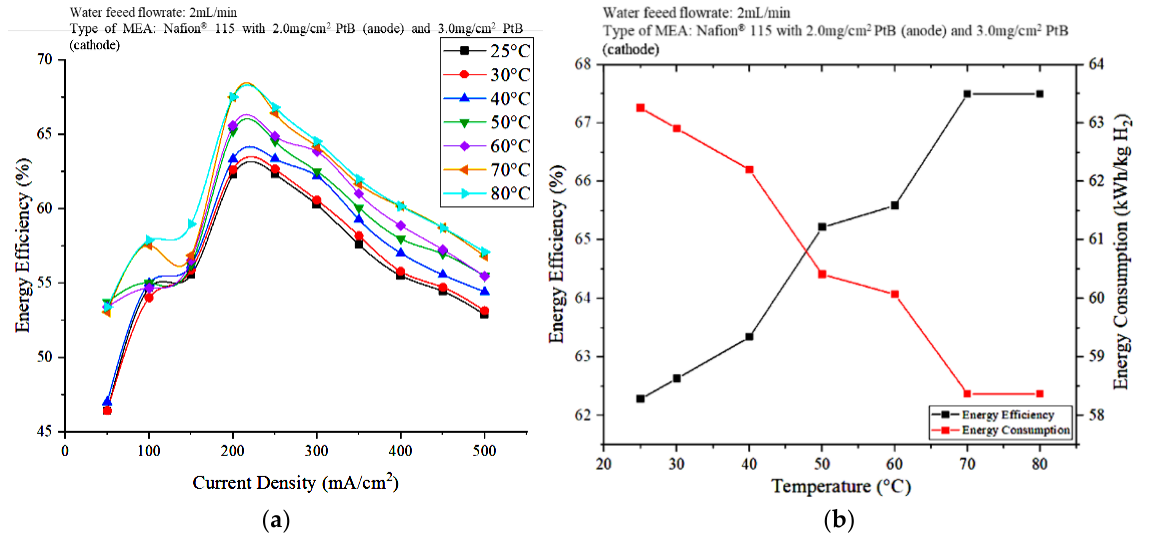
Figure 9. Effects of the operating temperature on ( a ) energy efficiency at different current densities and ( b ) energy efficiency and energy consumption at 200 mA/cm 2.